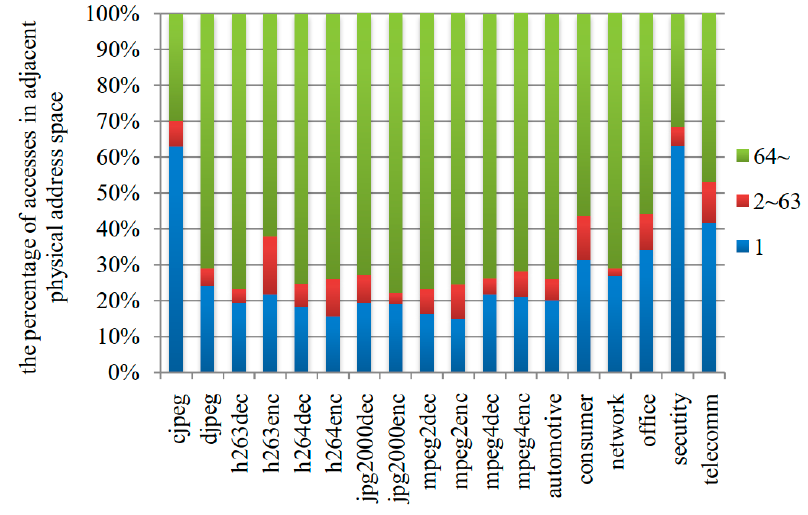
Figure 3. Spatial locality of IoT applications.